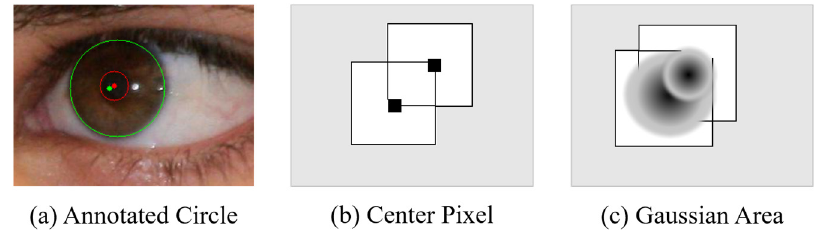
Figure 5. ( a ) Example of an iris, ( b ) inner ‐ /outer ‐ circle center, ( c ) and its Gaussian distribution. The centers of the inner and outer circles are highlighted in red and green, respectively. The Gaussian distributions of the inner and outer circles are shown in ( c ); the darker the color, the greater the